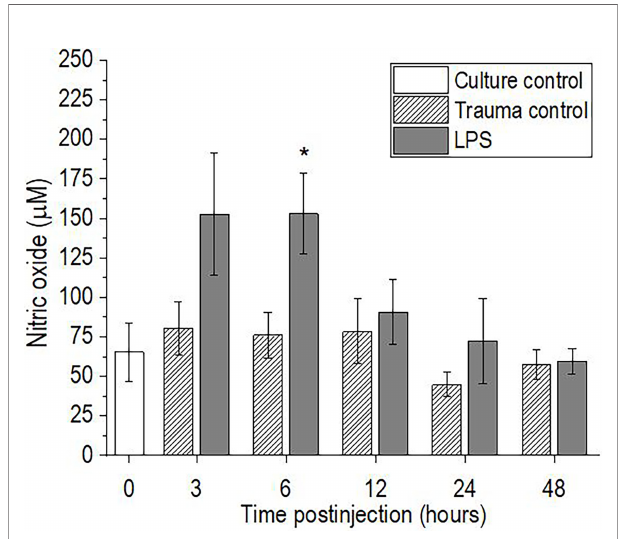
FIGURE 3 | Time-course of nitric oxide levels for the hemolymph of P. scaber injected with 0.5 m L DPBS (trauma control) and lipopolysaccharide (LPS; 0.5 m g/ m L). Culture control represents P. scaber not subjected to any injection. Data are means ± SE. *p <0.05, versus trauma control (n = 6).